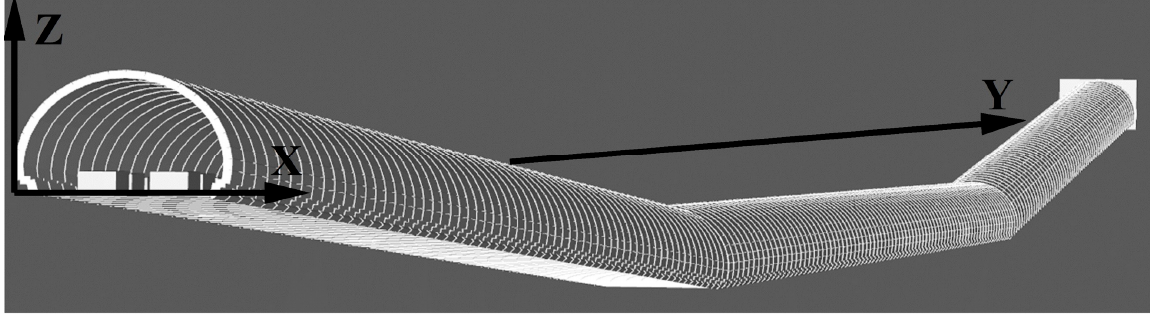
Figure 2. Schematic diagram of the full-scale 3D physical model of tunnel.